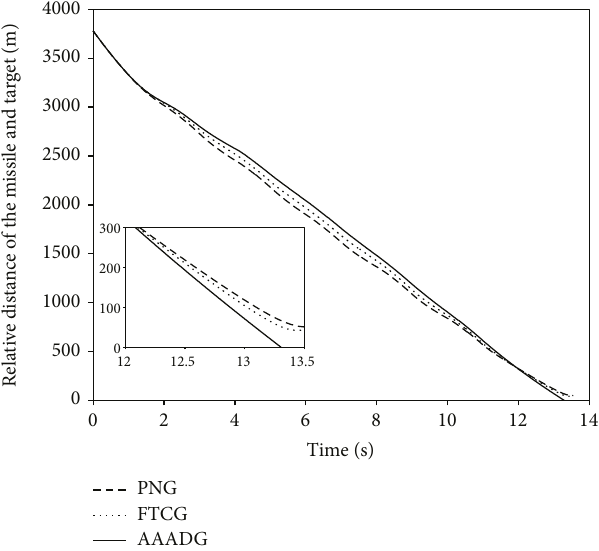
Figure 10: Relative distances between the interceptor and target under three guidance